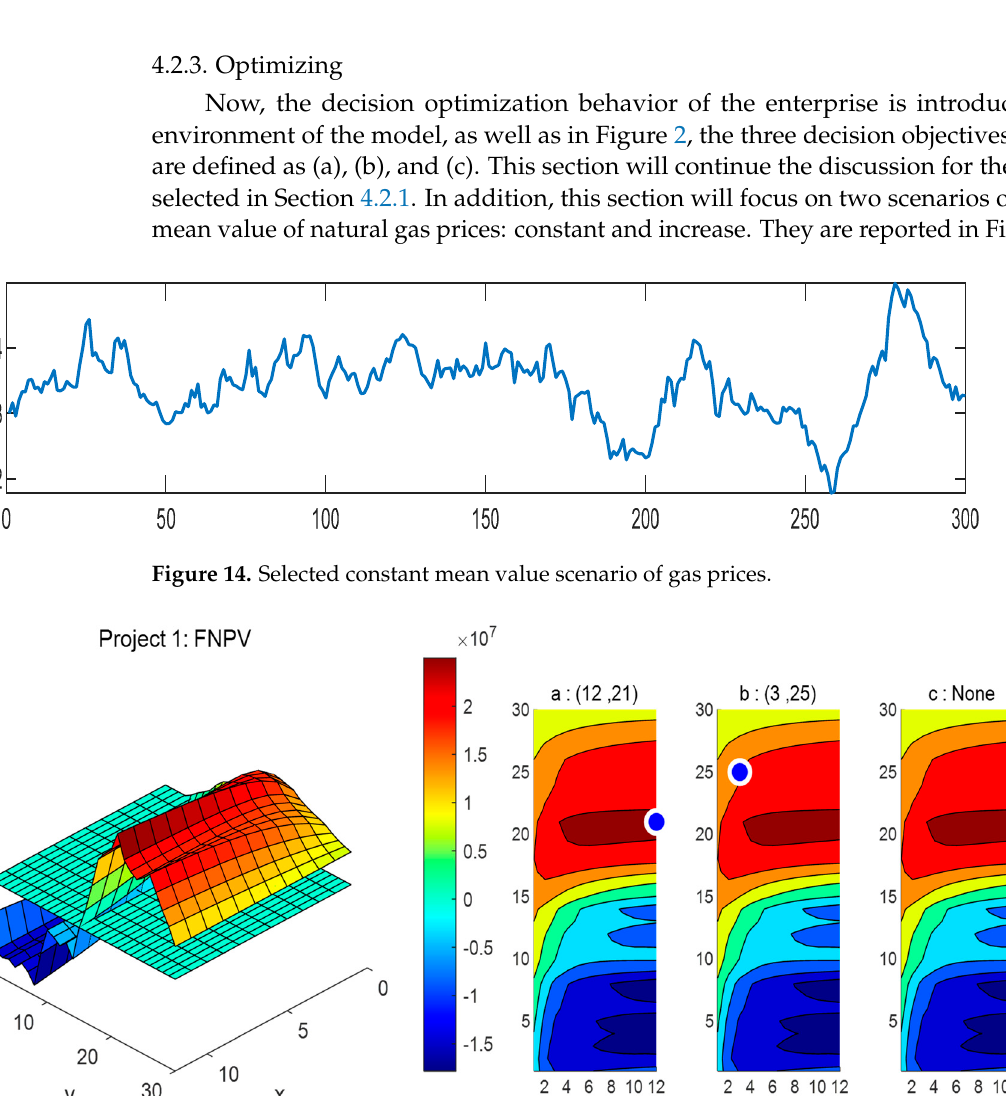
Figure 15. Decision-making for project 1. Figure 15. Decision − making for project 1.